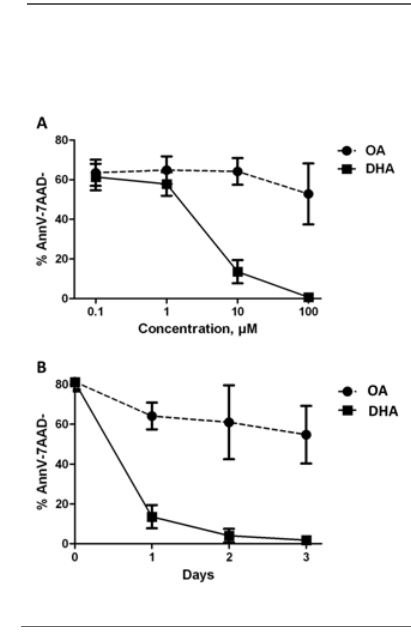
Figure 3. Effects of dose (A) and time (B) on DHA-induced apoptosis in primary CLL cells (10 samples). CLL cells viability was assessed by Annexin V-FITC/7-AAD immunostaining after exposure to DHA at concentrations ranging from 0,1 µM to 100 µM for 24 hours (A) and after expo- sure to DHA 10 µM for 24, 48 and 72 hours (panel B). Viable cells assessed by % of both Annexine V and 7-AAD negative are shown as mean ± standard error of mean. AnnV-7AAD-, Annexine V-negative and 7AAD-negative; OA, oleic acid; DHA, docosahexaenoic